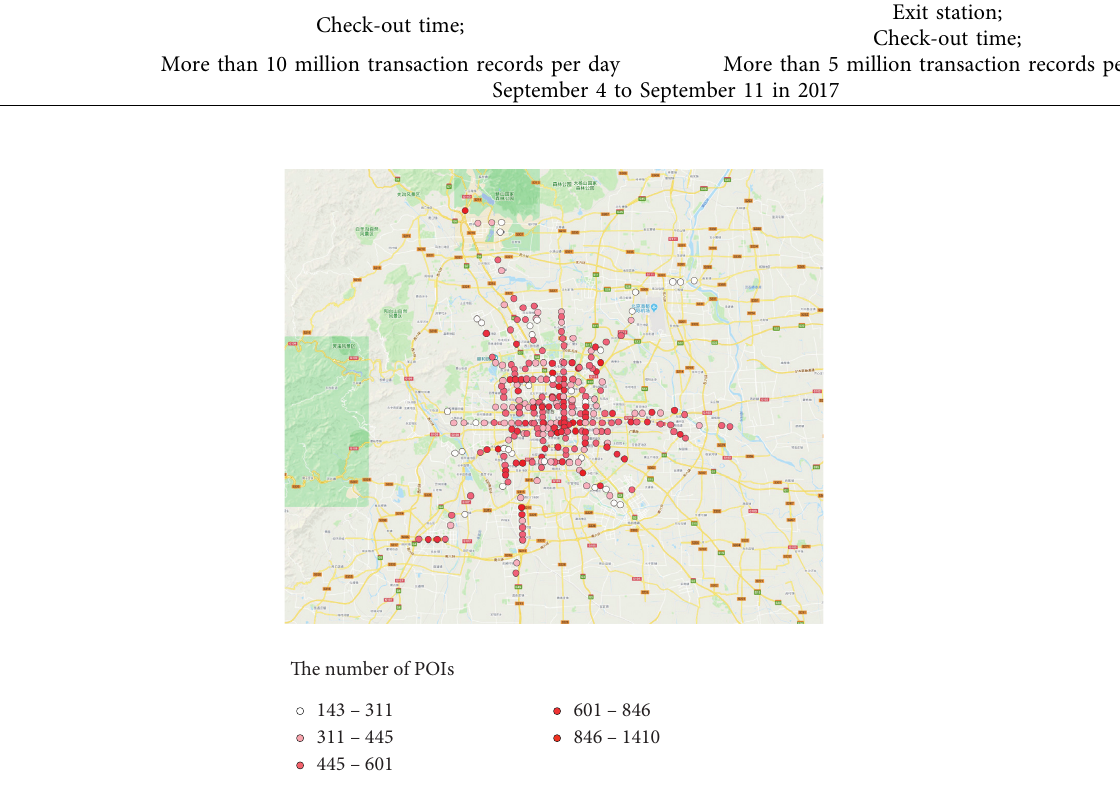
Figure 7: The number of POIs surrounding metro stations.